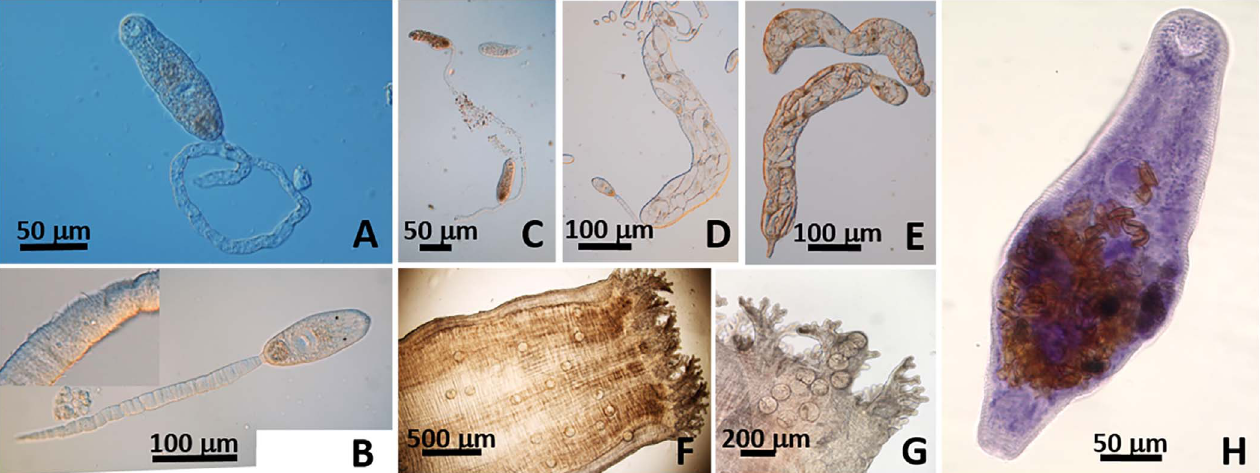
Figure 2. Lasiotocus trachinoti. (A – C) Cercaria distome with a pair of ocelli and a long retractile and spinose tail (B insert). (D – E) Large sporocysts with terminal birth pore. (F – G) Metacercariae in situ in inhalant siphon in D. variabilis . (H) Adult (Mayer ’ s hematoxylin) from intestine of Florida Pompano, Trachinotus carolinus